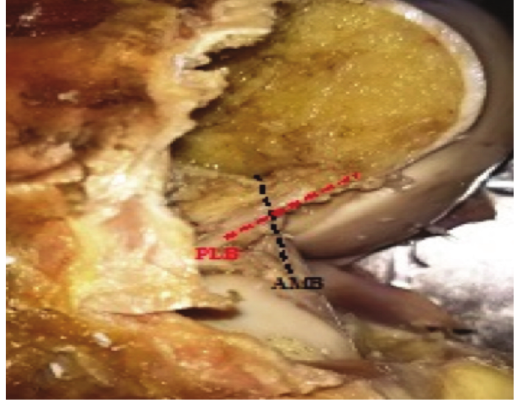
Twisting of bundles at 90° knee Fig. 5: